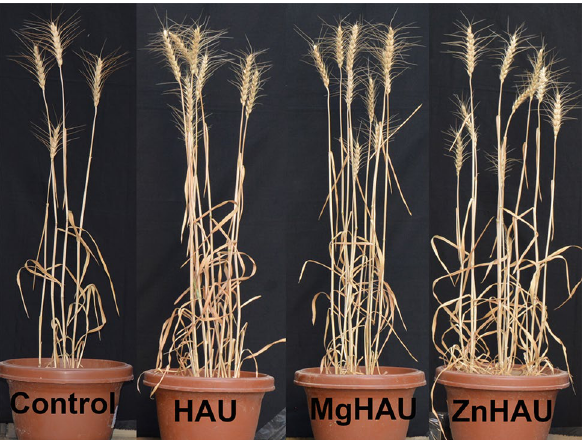
Figure 5. Wheat plants (at maturity) treated with nitrogen fertilizers, left to right: Control (Urea Fertilizer-100% RD NPK ), HAU (Hydroxyapatite-Urea 50% Suspension-50% RD N + 100% RD PK ), MgHAU (Mg doped-Hydroxyapatite-Urea 50% Suspension-50% RD N + 100% RD PK ), and ZnHAU (Zn doped-Hydroxyapatite- Urea 50% Suspension-50% RD N + 100% RD PK ) in a pot experiment